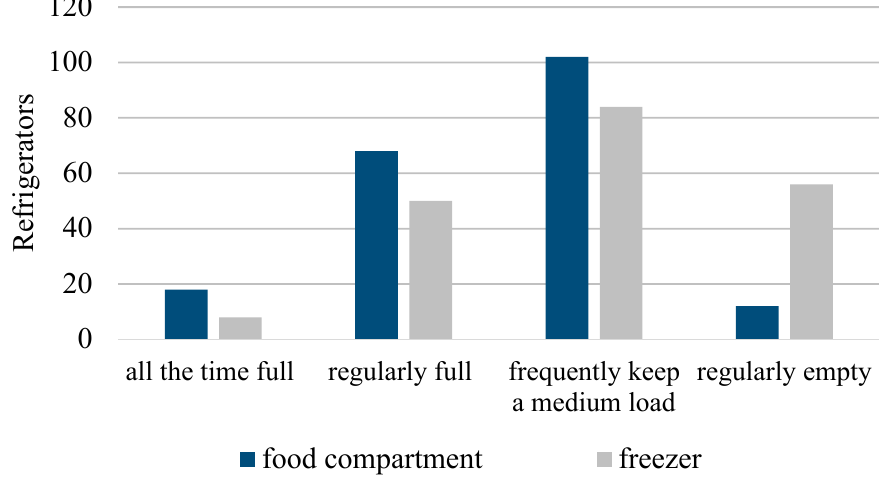
Figure 7. Food load in the refrigerator compartments.